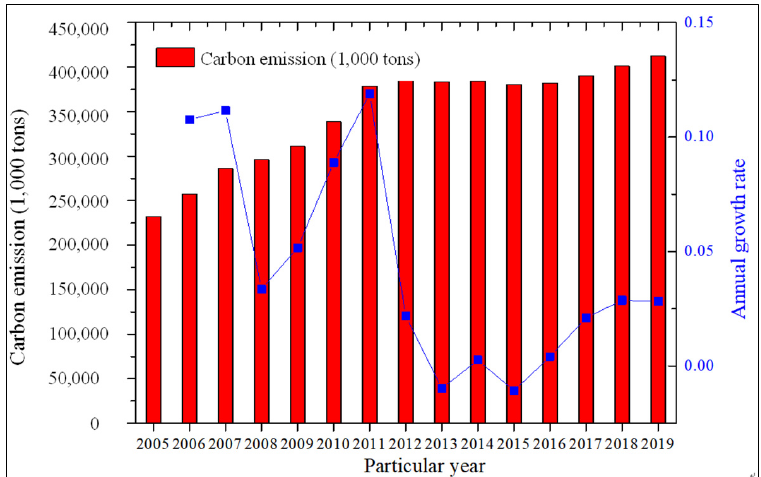
Figure 1. Carbon emission and increase rate of 30 provinces in China from 2005 to 2019.